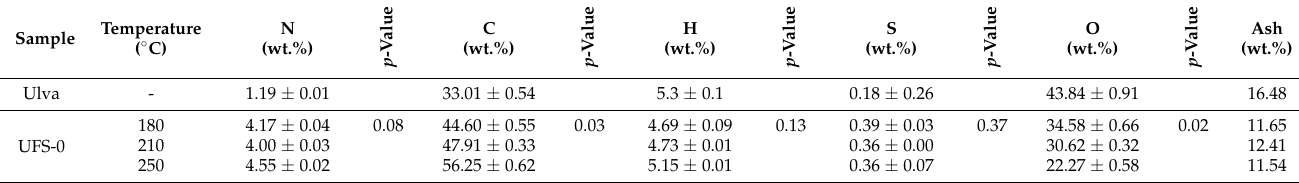
Table 1. Elemental analysis of